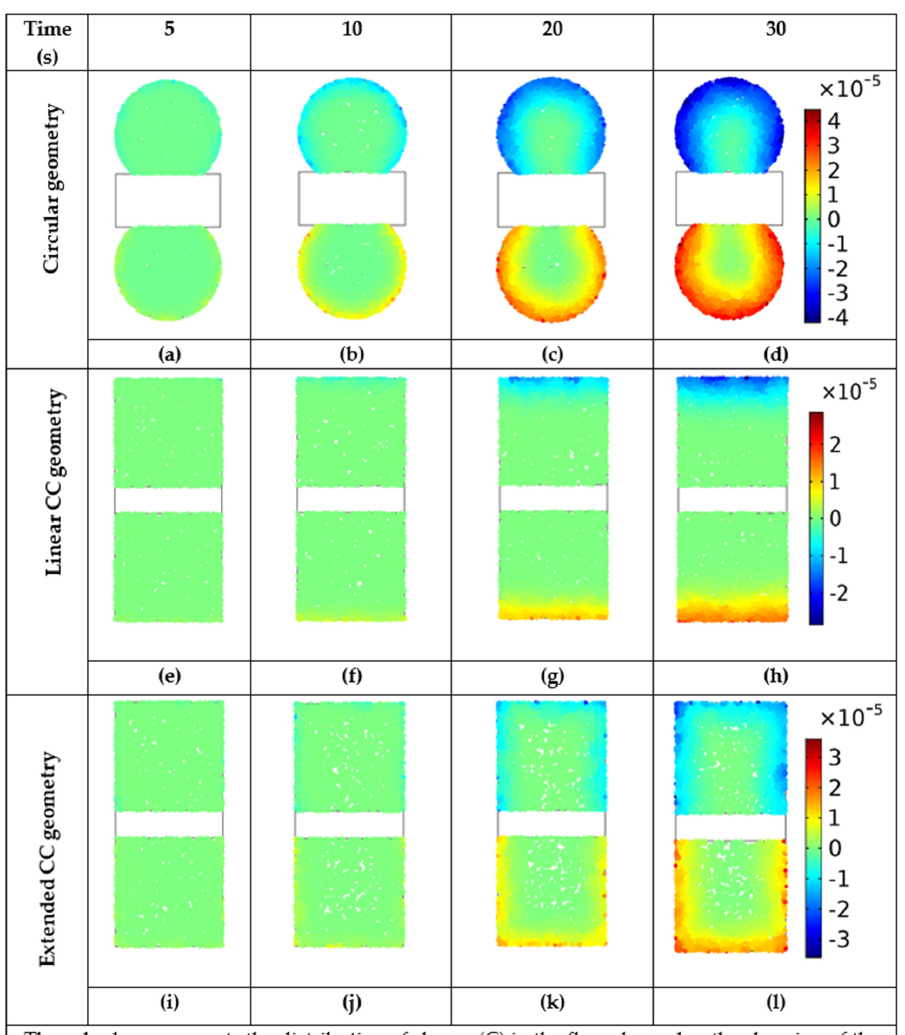
plementary Materials: Figure S1 for the circular geometry design, Figure S2 for box-shaped geometry with a linear CC, and Figure S3 for box-shaped geometry with an extended CC.